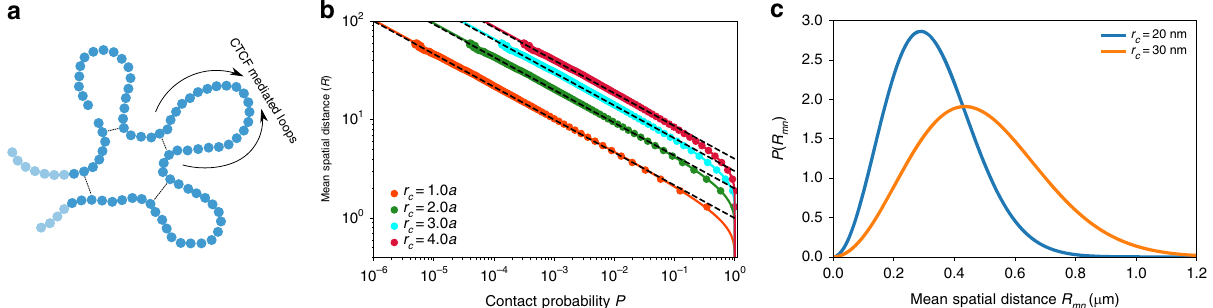
Fig. 1 Simulations demonstrate the power-law relation between contact probability and mean spatial distance and the effect of r c on the inferred spatial distances. a A sketch of the Generalized Rouse Model for Chromosome (GRMC). Each bead represents a locus with a given resolution. Dashed lines represent harmonic bonds between loop anchors. b Mean spatial distance 〈 R 〉 as a function of the contact probability P . The solid lines are obtained using Eq. (1) for different values of r c (shown in the fi gure), the threshold distance for contact formation. The dots are simulation results. The agreement between simulations and theory is excellent. Asymptotically 〈 R 〉 approaches r c P − 1/3 (dashed lines). The threshold for contact is expressed in terms of a , which is the equilibrium bond length in Eq. (15). c Illustration of the sensitivity of r c in determining the mean spatial distance 〈 R 〉 . Blue and yellow curves are computed by solving 〈 R 〉 (Eq. (1)) for a given contact probability P mn = 10 − 3 , and r c . The calculated 〈 R mn 〉 is used in Eq. (10) to obtain the distribution of the spatial distance P ( R mn ). Blue and yellow curves are for the same value of P , but different r c